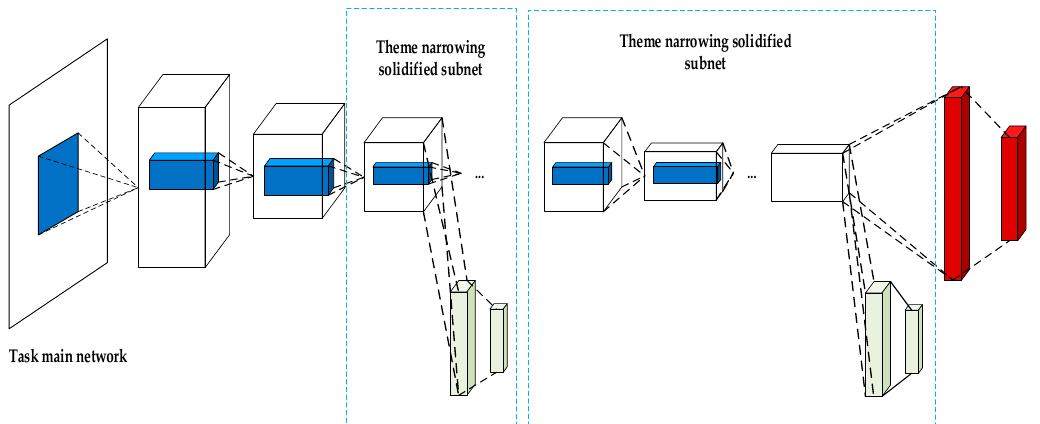
Electronics 2019 , 8 , 959